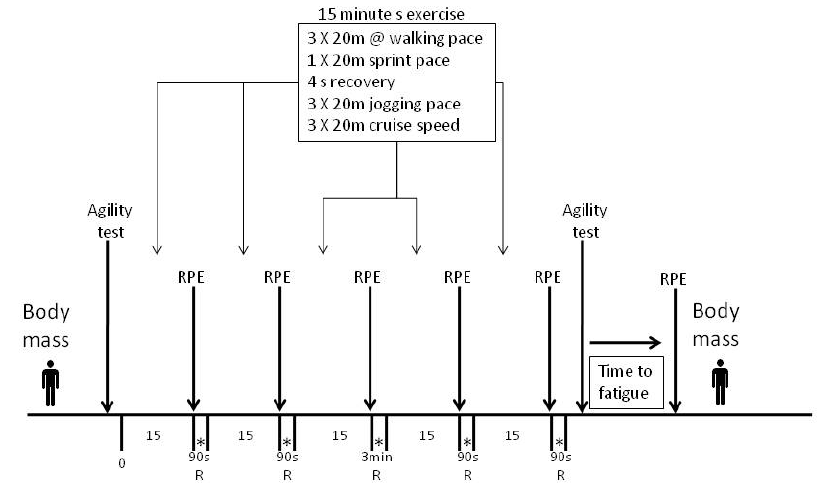
Figure 1. Schematic representation of the simulated soccer match adapted from the modified Illinois agility test [18] and the Loughborough Intermittent Shuttle Test (LIST) [8]. RPE, rating of perceived exertion; R, rest; * ingested 50